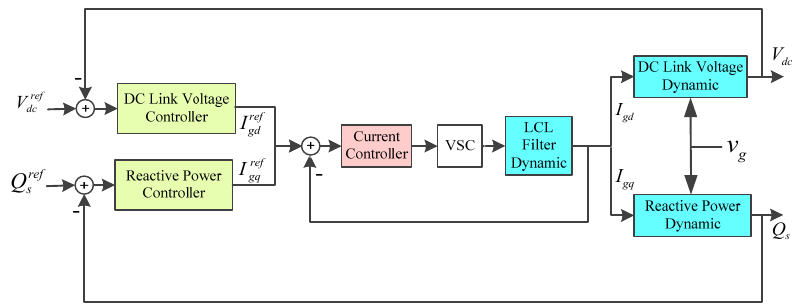
Figure 2. Double loop control structure of the grid-connected inverter.